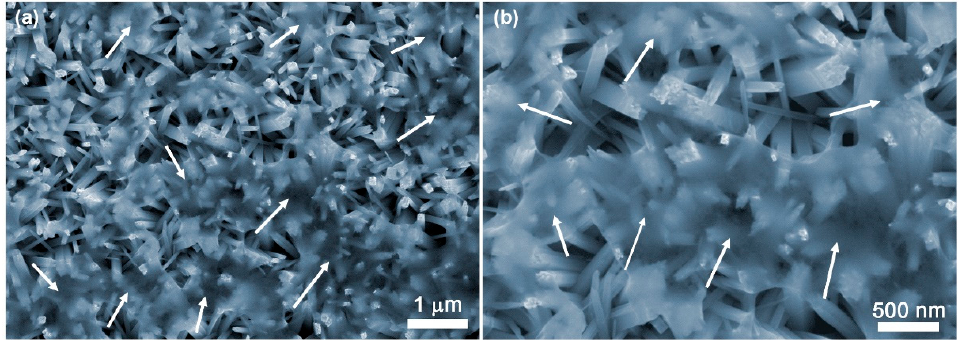
Figure 1. ( a , b ) Top-view SEM images of T-Ni(OH) 2 @TiO 2 films. T-Ni(OH) 2 overlayer is indicated by